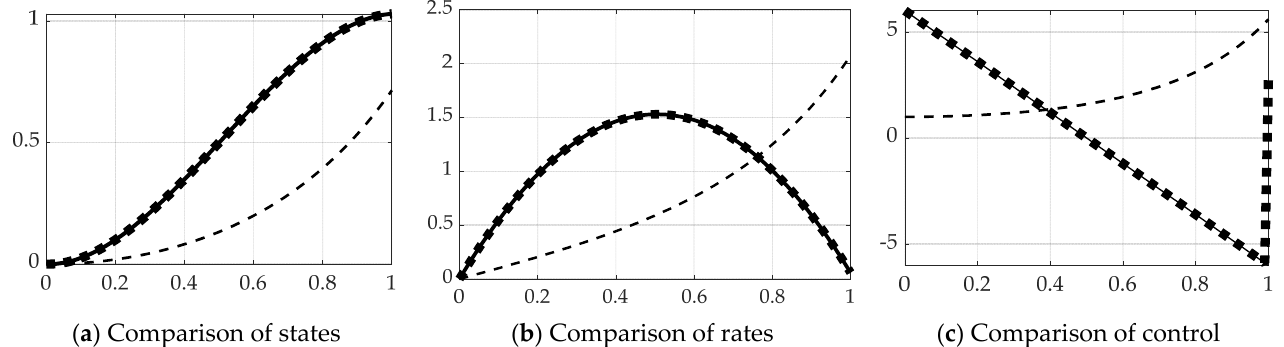
Figure 7. Comparison of real-time optimal methods with scaled time on the abscissae and respective ordinates titled in the subplot captions: solid line is open loop optimal (benchmark), dashed line is real-time optimal using backslash , thick dotted line is real-time optimal using backslash with singular switching. ( a ) States, ( b ) rates. Notice the solid black line representing the optimal open loop solution in subfigure ( c ) is initially positive to create movement in the desired direction, and the control switches exactly at the halfway point to a negative input, slowing progress towards the final desired end states (position and rate states). The ranges of the zoomed view in the inset are indicated by the respective scales.